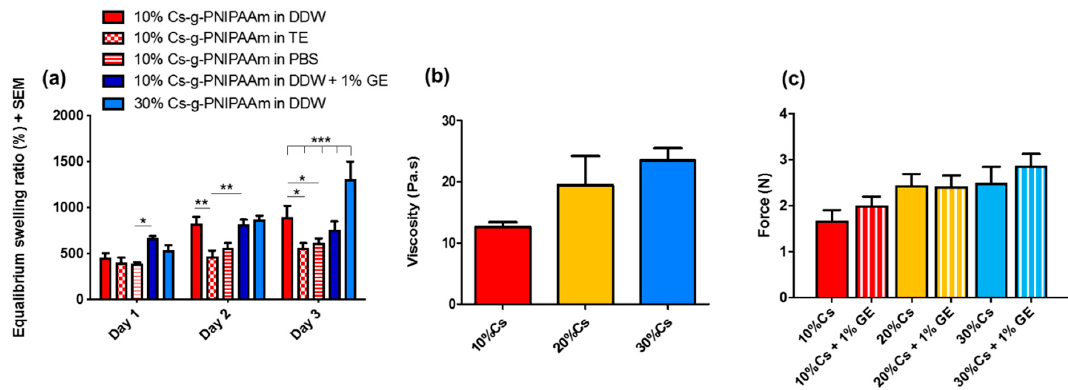
Figure 5. ( a ) Swelling behavior of Cs-g-PNIPAAm hydrogels in different media (PBS, DDW, and Tris-EDTA (TE) buffer). ( b ) Viscosity of the hydrogels determined in a flow mode at 20 °C. ( c ) Force required to inject 200 µ L hydrogel through 25-G needle and viscosity of copolymers measured via rheological measurement in flow mode.